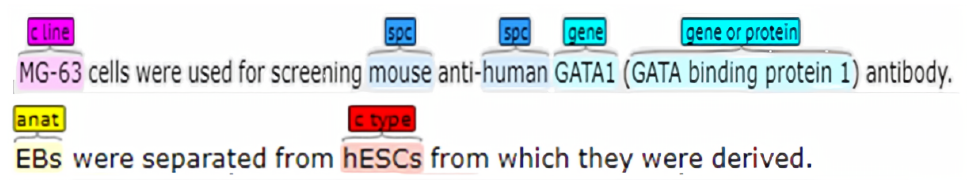
Figure 1. An illustration of the biomedical named entity recognition